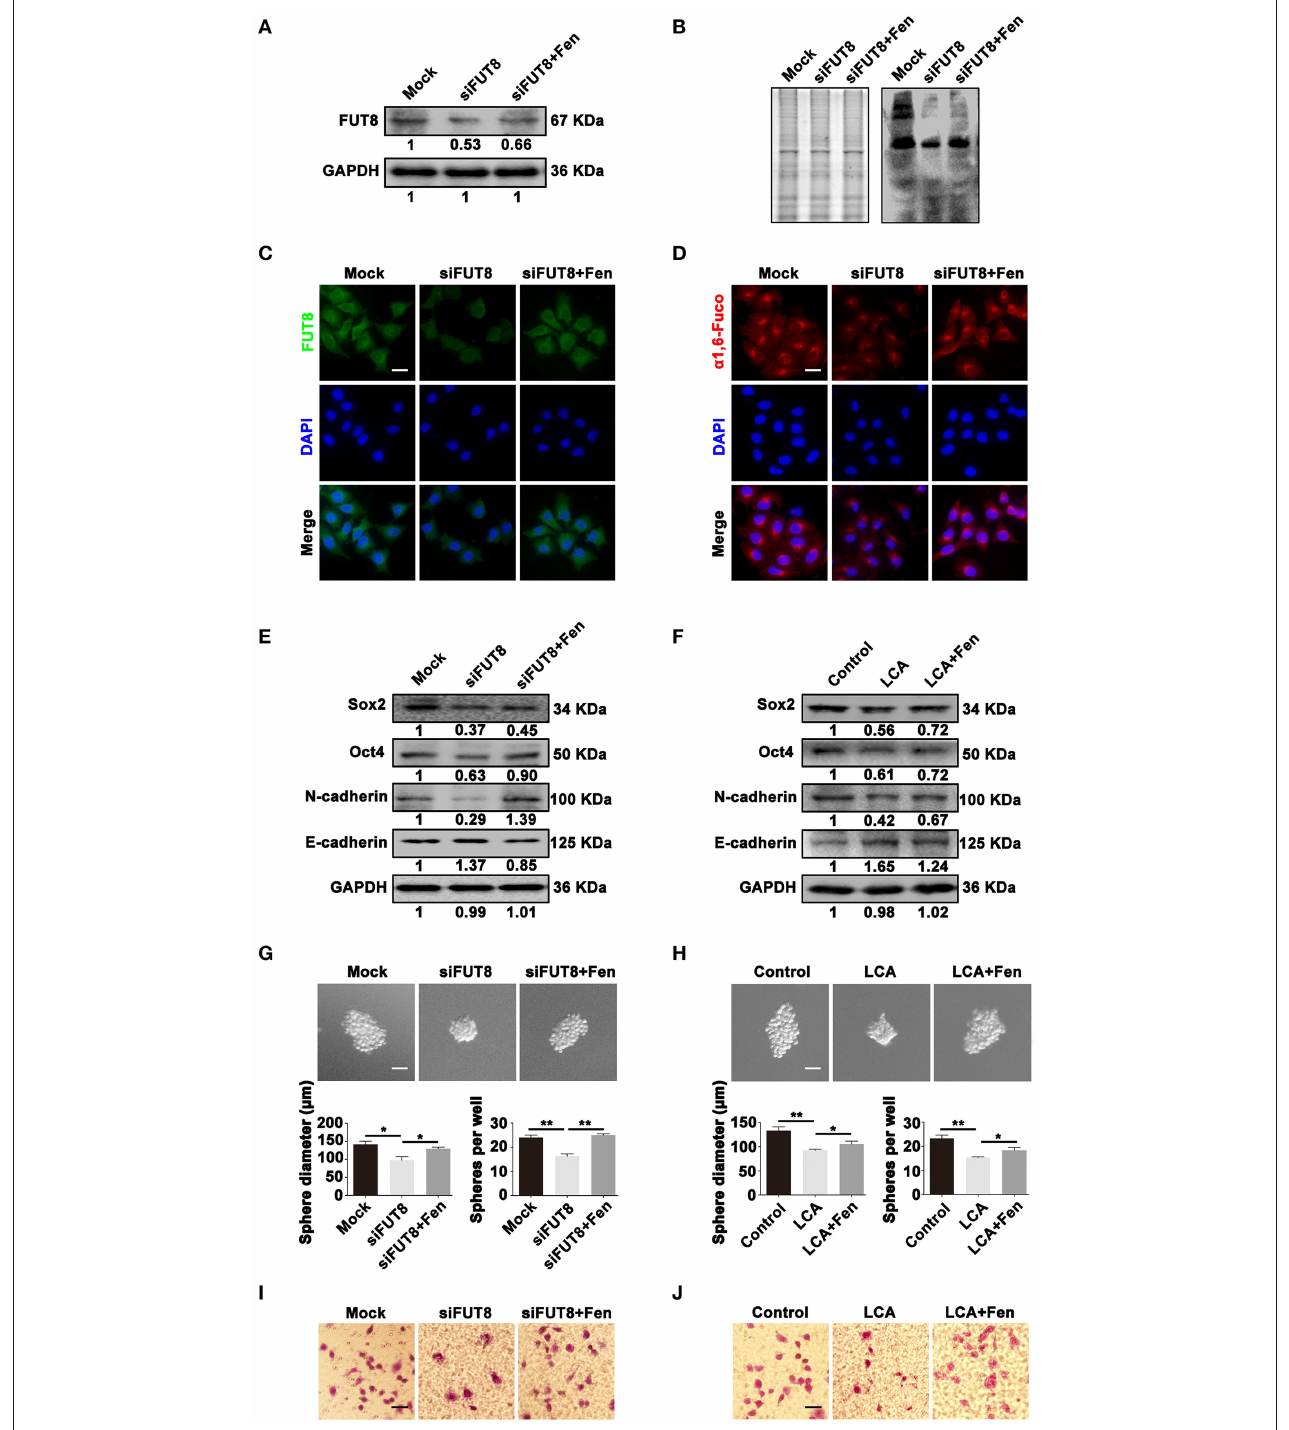
FIGURE 4 | α 1, 6-fucosylation is involved in fentanyl-mediated stemness and EMT. (A,B) Western blot, Lectin blot (C,D) immunofluorescent staining and Lectin fluorescent staining analysis for expression of FUT8 and α 1, 6-fucosylation in mock, siFUT8 or siFUT8 + fentanyl group. (E,F) Western blot analysis for Sox2, Oct4, N-cadherin and E-cadherin potein expression. (G) Representative images of tumor-spheres in mock, siFUT8 or siFUT8 + fentanyl group observed under a microscope after 12 days of incubation. (Scale bars = 50 µ m; Magnification, 200 × ). (H) Images of tumor-spheres in control, LCA or LCA + fentanyl group. (I) Images of migrated MCF-7 cells in mock, siFUT8 or siFUT8 + fentanyl group observed under a microscope. (J) Images of migrated MCF-7 cells in control, LCA and LCA + fentanyl (0.1 µ M) groups. (Scale bars = 50 µ m; Magnification, 200 × ). Data are represented as mean ± SD ( n = 3). Statistical significant different in sphere diameter and sphere per well (* P < 0.05; ** P <